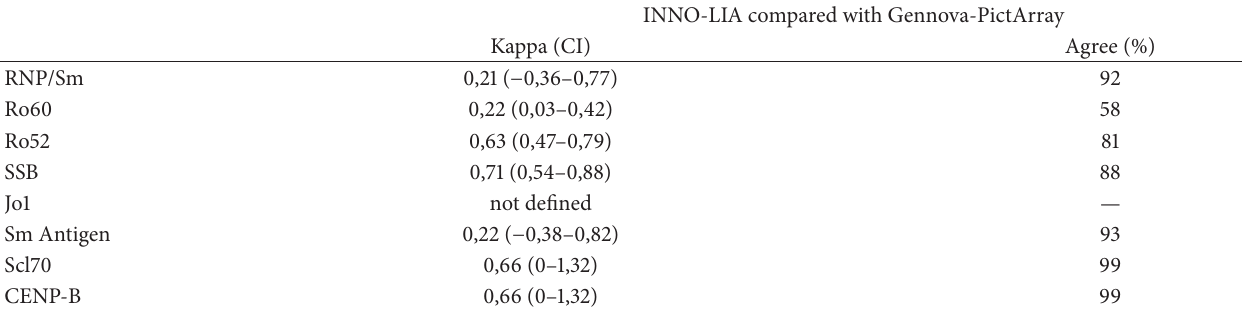
Table 5: Results for connective tissue diseases group. Concordance between INNO-LIA and Gennova-PictArray. INNO-LIA compared with